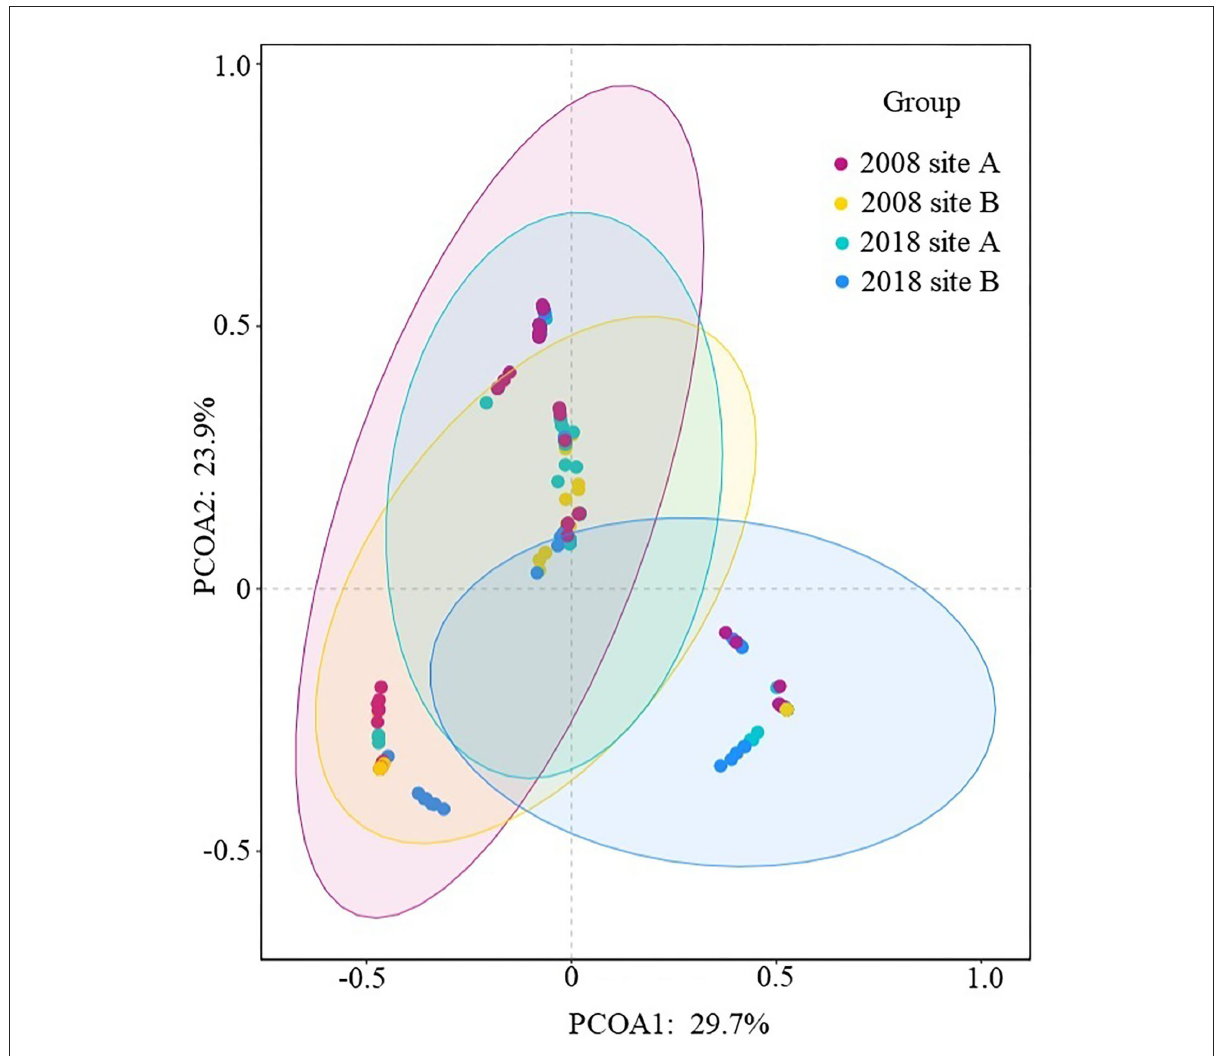
FIGURE5 Similarity in species composition in coastal